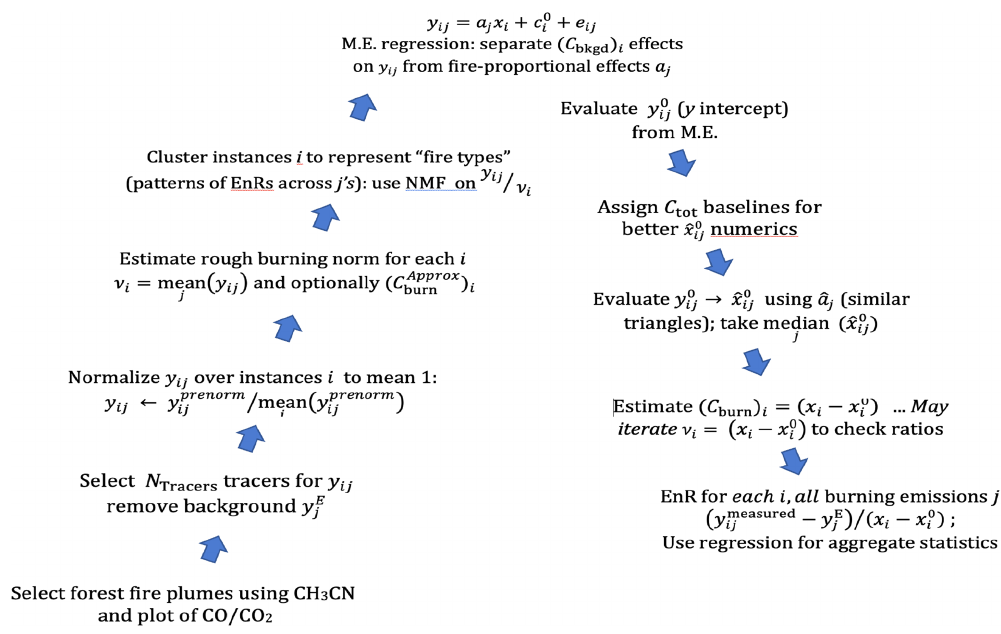
Figure 8. Summary of the MERET algorithm. See text for further